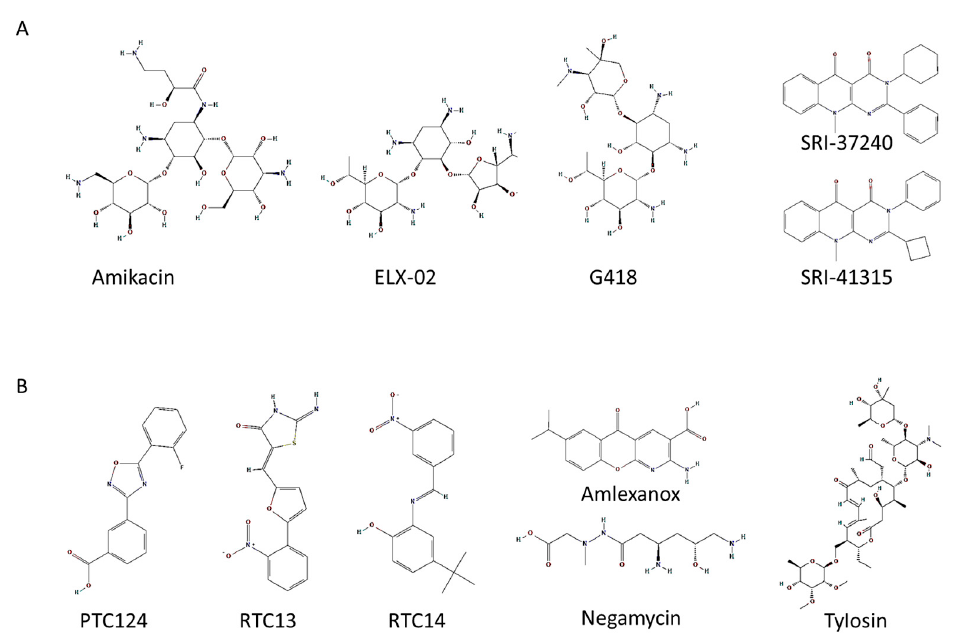
Figure 2. Some of the chemical structures of the compounds mentioned in Table 1 ( A ) and Table 2 ( B ). (Chemical structures modified from https://pubchem.ncbi.nlm.nih.gov/, accessed on 18 February 2023) .